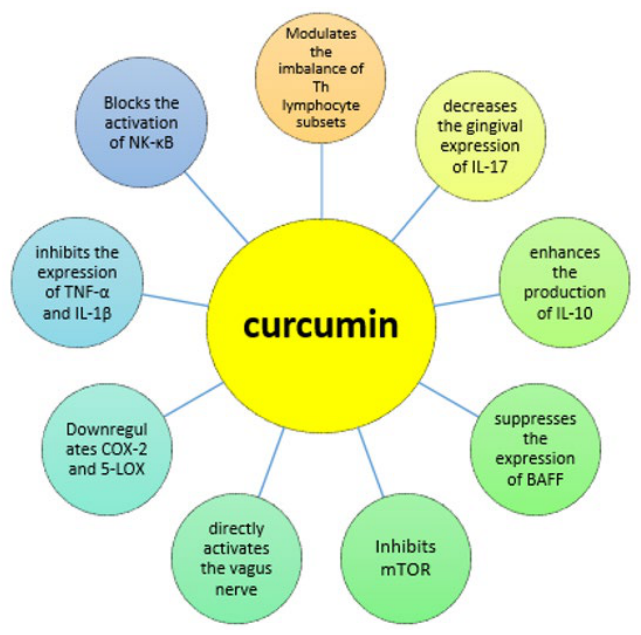
Figure 1. Mechanism of action. COX-2 = cyclo-oxygenase-2, 5-LOX = 5-lipoxygenase, mTOR = mam-malian target of rapamycin, BAFF = B cell activation factor, IL = interleukin, Th = T helper cells, NK- κ B = nuclear factor kappa-light-chain-enhancer of activated B cells, TNF = tumor necrosis factor.